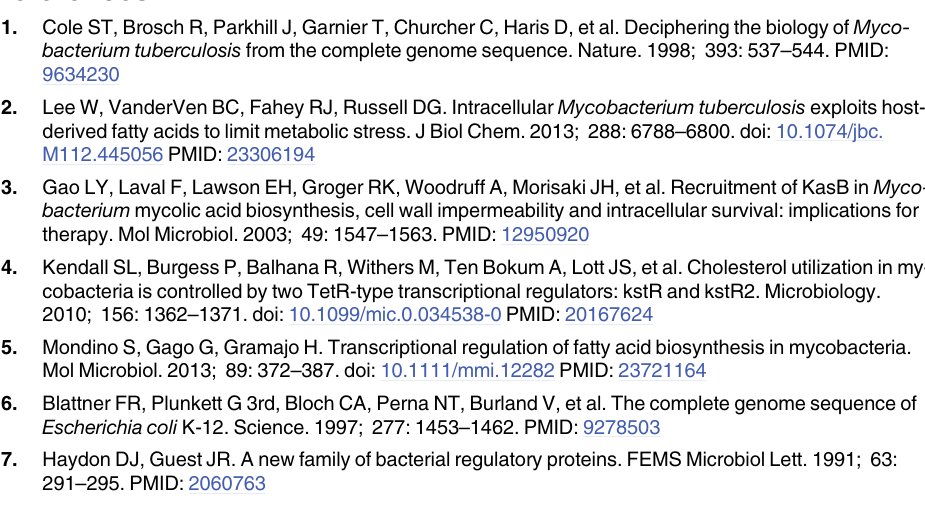
S1 Fig. Crystal packing representations of Fad35R along crystallographic y-axis. Two monomers of canonical dimer (blue and yellow) are presented by capital letters A-F (on top) and two mononers of alternative dimers (blue and yellow) are represented by small letters a-f (on top). The repeated arrangement of canonical and alternative arrangement creates a supera- molecular assembly on the y-axis. The respective dimerization interfaces are shown at the bottom. (DOC) S2 Fig. Sedimentation velocity profiles of Fad35R in the presence of 100.0 μ M tetracycline. The y-axis represents optical density of the sample, monitored at 280 nm and x-axis represents radius along the cell. Due to relatively high absorbance of tetracycline at 280 nm and sample heterogeneity induced by tetracycline, the absorbance profiles are scattered. (DOC) S1 Table. Interactions that stabilize canonical dimer interface. (DOC) S2 Table. Interactions that stabilize alternative dimer interface. (DOC) S3 Table. Particle size analyses of